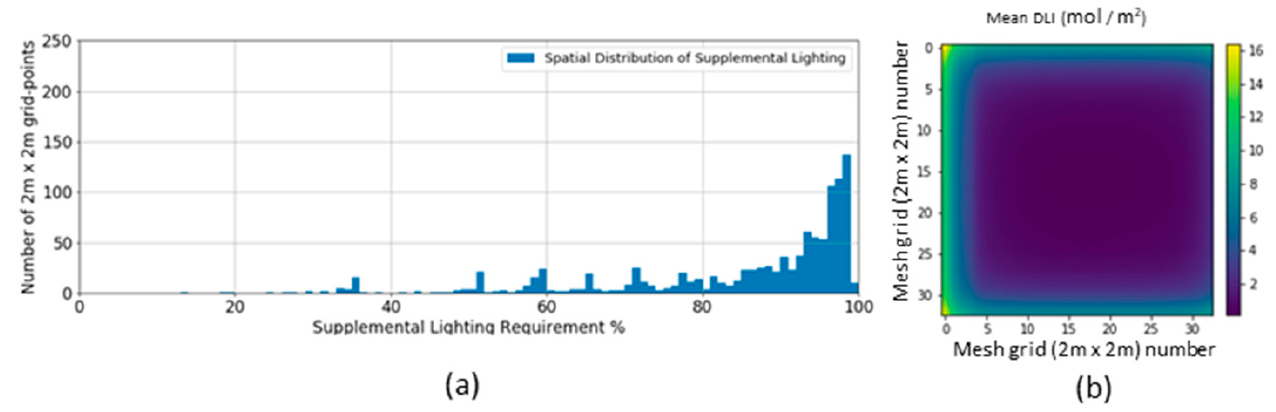
Figure 4. ( a ) Distribution of supplemental lighting requirements at 19th level of Geometry 3 in Los Angeles and ( b ) map of mean DLI of natural light throughout building interior.